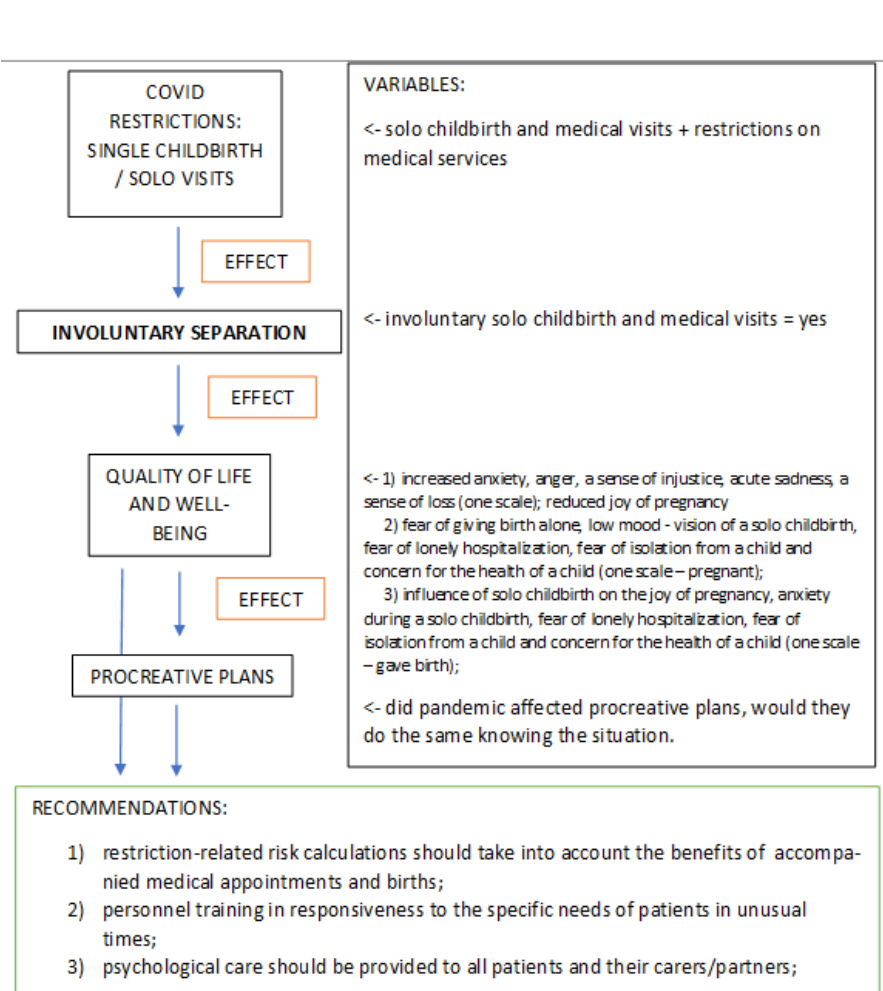
Figure 1. Involuntary separation-measured variables, income and outcome.